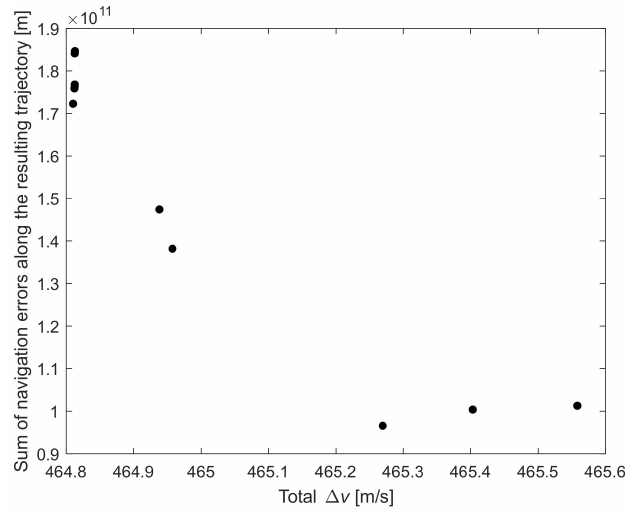
Figure 16. Sum of navigation errors along the resulting trajectory vs. fuel cost.